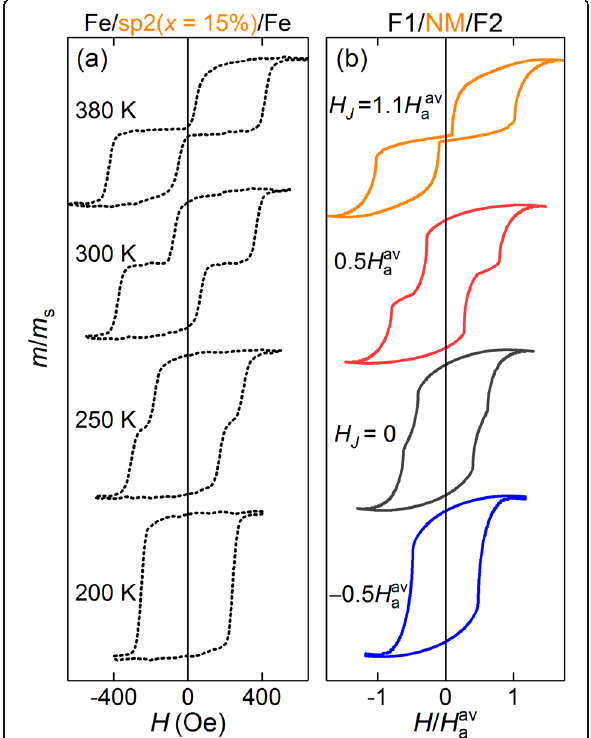
Fig. 4 a Magnetization versus field measured by the MOKE for sample from second series, Fe/sp2( x =15%)/Fe, for different temperatures. b Corresponding simulated M ( H ) curves for model F1/NM/F2 trilayer, for different effective field of indirect exchange coupling, H